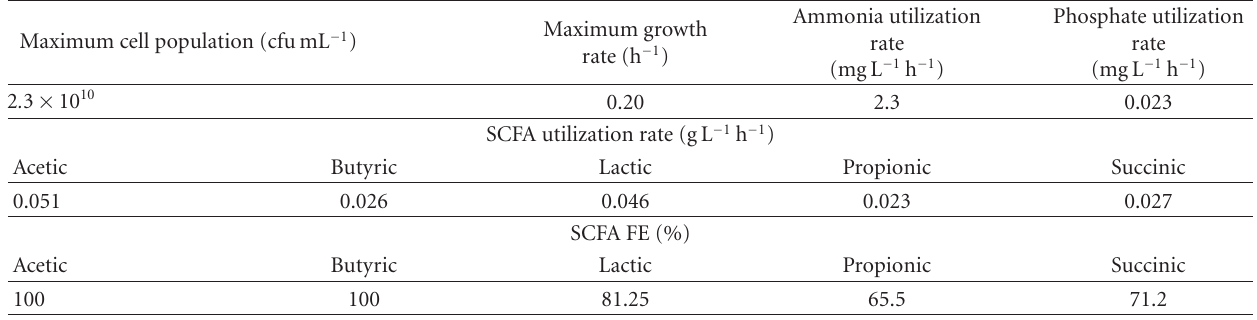
Table 2: Average growth and nutrient utilization rates of R . eutropha in CCS medium through 48 h in biorector.